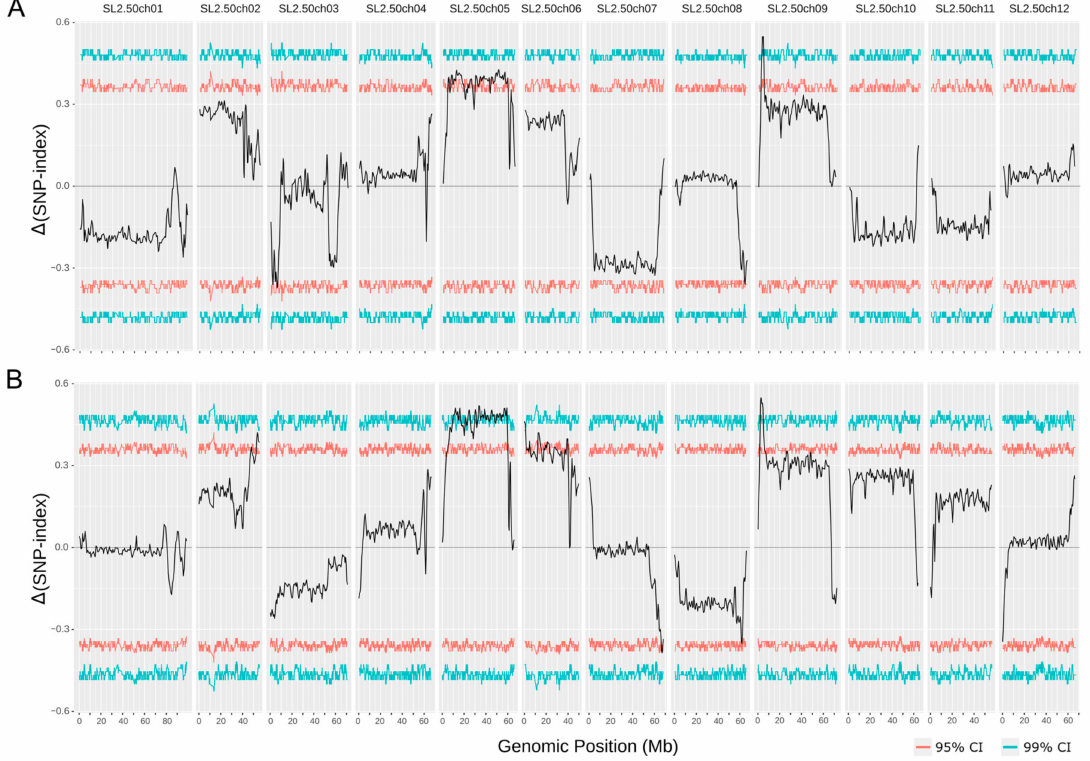
Figure 5. Distribution of ∆ (SNP-index) along the chromosomes based on 1 Mb windows for the ( A ) SLC family (BGV016047 × LA2278) and ( B ) SLL family (BGV016047 × MoneyMaker). The 95% and 99% confidence thresholds are